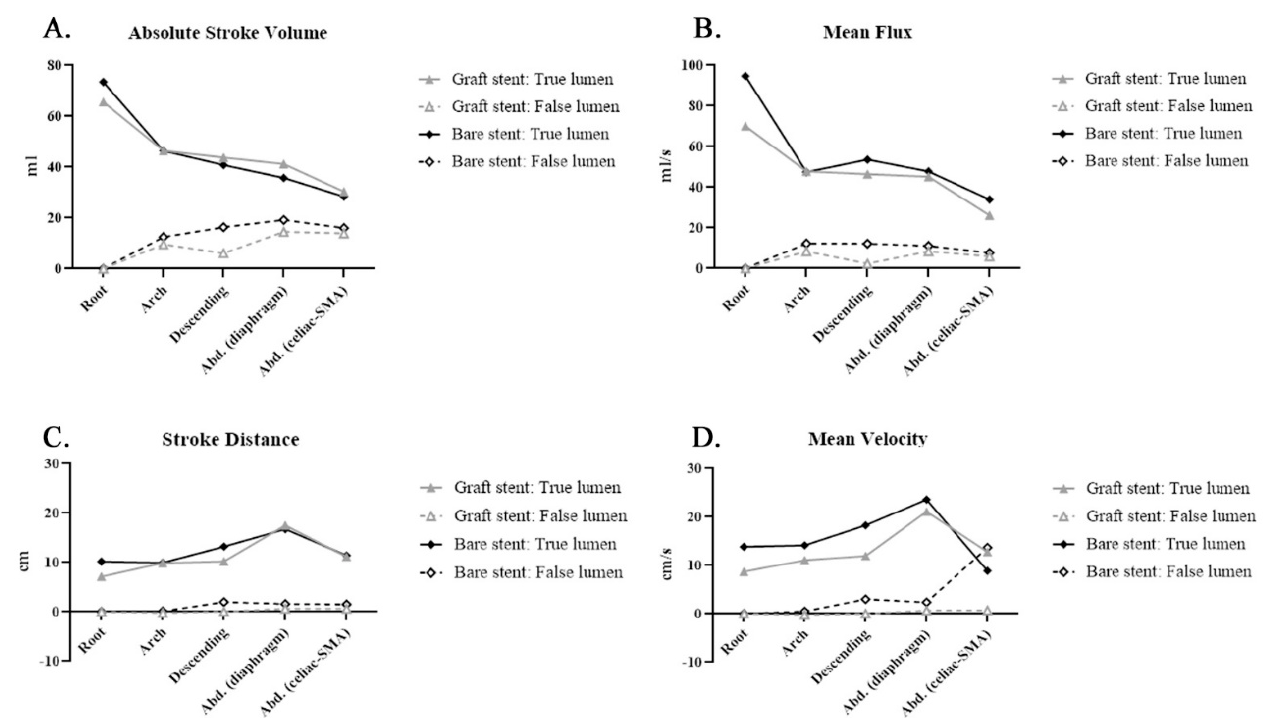
Figure 5. Covered (graft) stent and bare stent: Phase-contrast magnetic resonance imaging (PC-MRI) quantitative flow measurements after thoracic endovascular aortic repair (TEVAR) compared with those before TEVAR: ( A ) absolute stroke volume (ASV): ASV in the false lumen was higher in the bare stent group, indicating fewer communicator occlusions by the bare stent in the thoracic aorta; ( B ) mean flux (MF): MF was higher in the true lumen in patients with bare stents; ( C ) stroke distance (SD): SD in the true lumen was smaller in patients with bare stents than in those with covered stents after thoracic endovascular aortic repair (TEVAR); ( D ) mean velocity (MV): MV was higher in the descending segment but lower in the abdominal aorta in the bare stent group than in the covered stent group after TEVAR.